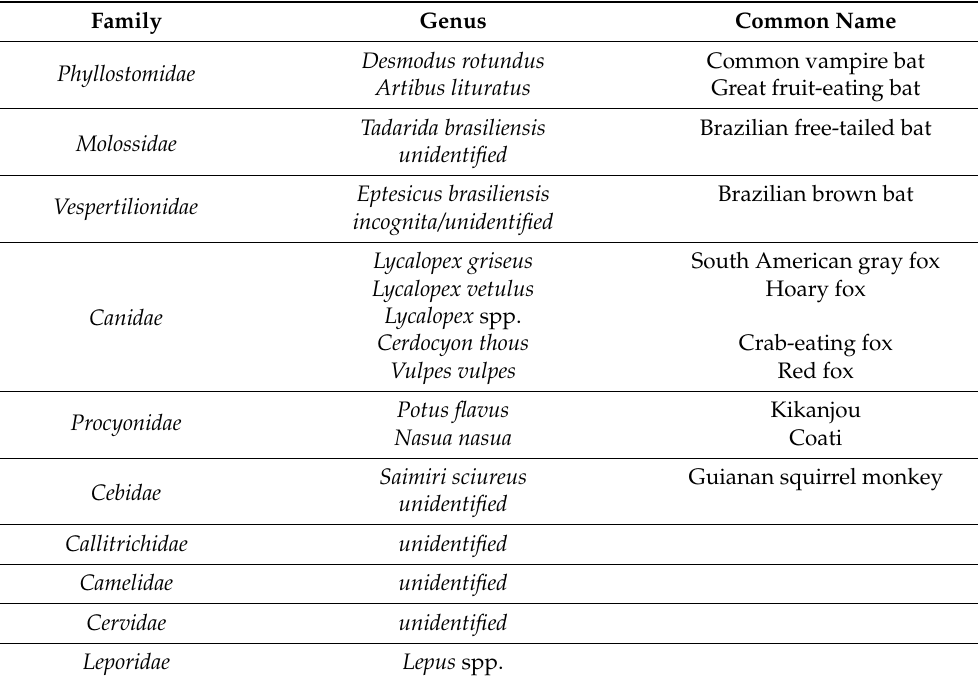
Table 3. Rabies cases reported in wildlife at family, genus or species level.